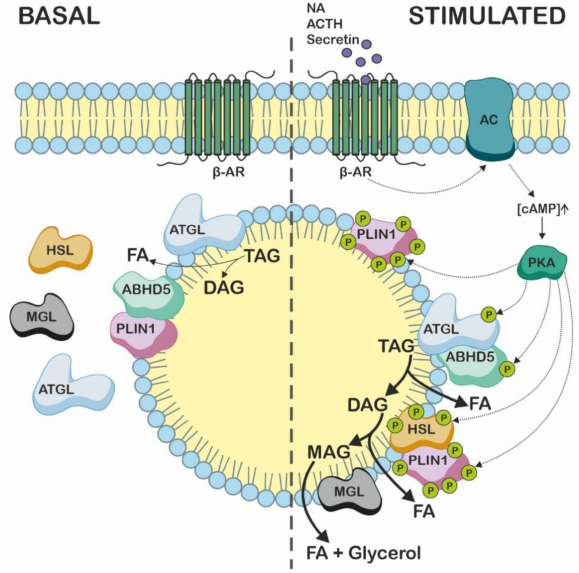
Figure 5. Schematic representation of basal and stimulated lipolysis in adipose tissue. Under basal conditions, perilipin 1 (PLIN1) binds α / β hydrolase domain containing protein 5 (ABHD5) and prevents the interaction of ABHD5 with adipose triglyceride lipase (ATGL), thereby suppressing lipolysis. ATGL, hormone-sensitive lipase (HSL), and monoacylglycerol lipase (MGL) are primarily located in the cytosol; however, low levels of ATGL are associated with lipid droplets and enable basal lipolysis. Activation of β -adrenergic receptors ( β -AR) by noradrenalin (NA), adrenocorticotropic hormone (ACTH), or secretin leads to increased adenylate cyclase (AC) activity, resulting in an increase in cAMP levels. cAMP activates protein kinase A (PKA), which phosphorylates PLIN1, ATGL, ABHD5, and HSL. The phosphorylation of PLIN1 releases phosphorylated ABHD5, which then interacts with phosphorylated ATGL to stimulate triacylglycerol (TAG) degradation. Moreover, phosphorylated PLIN1 recruits phosphorylated HSL to the surface of lipid droplets, which hydrolyzes diacylglycerol (DAG) to monoacylglycerol (MAG). In the final step of lipolysis, MGL releases the last remaining fatty acid (FA) from the glycerol